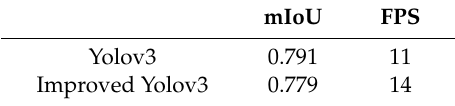
Table 3. Performance comparison of standard Yolov3 and improved Yolov3 on test set.